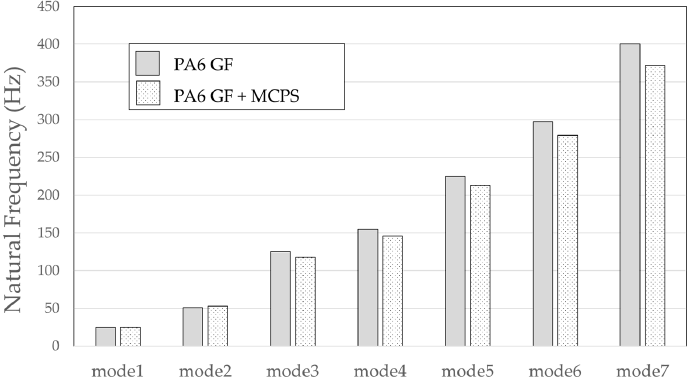
Figure 14. Effect of MCPs on natural frequencies of the roof-rack specimen.